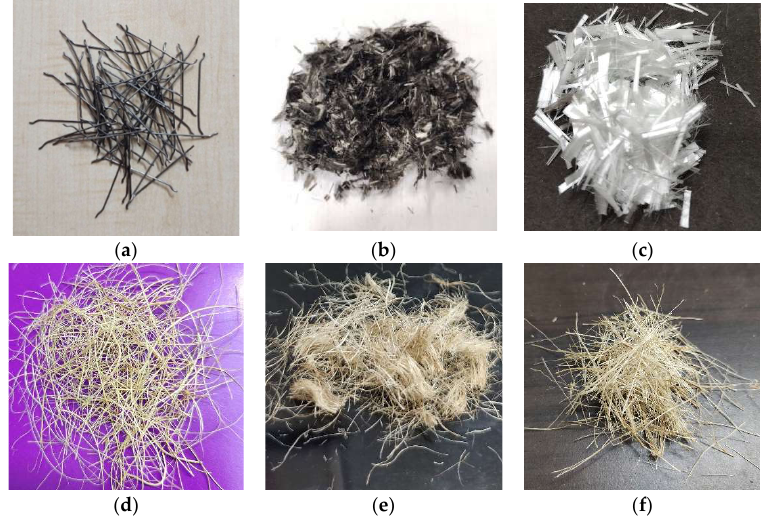
Figure 1. Chopped fibres ( a ) Steel fibre, ( b ) Carbon fibre, ( c ) Glass fibre, ( d ) Coir fibre, ( e ) Jute fibre, ( f ) Sisal fibre. Table 1. Properties of raw fibres.